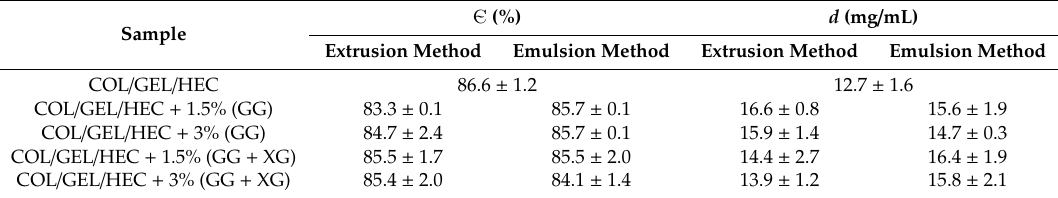
Table 3. Porosity ( Є ) and density ( d ) of COL / GEL / HEC porous matrices containing microspheres based on gellan gum and xanthan